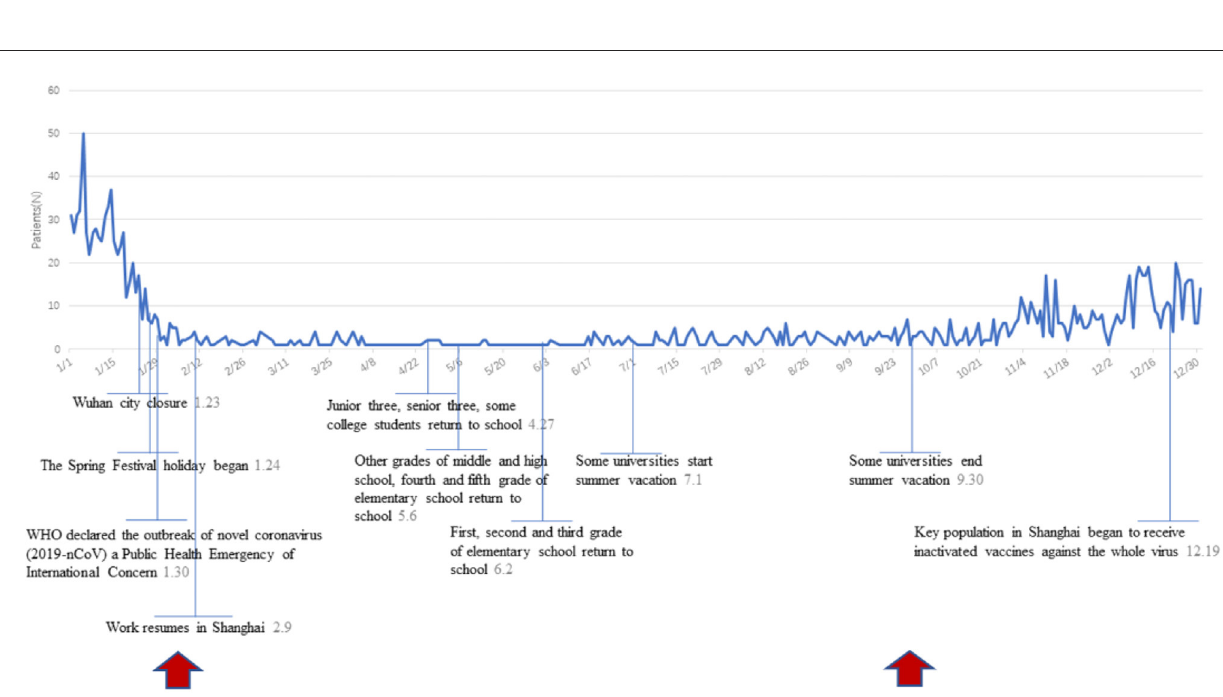
FIGURE3 Daily AOM outpatients following time series chart of COVID-19